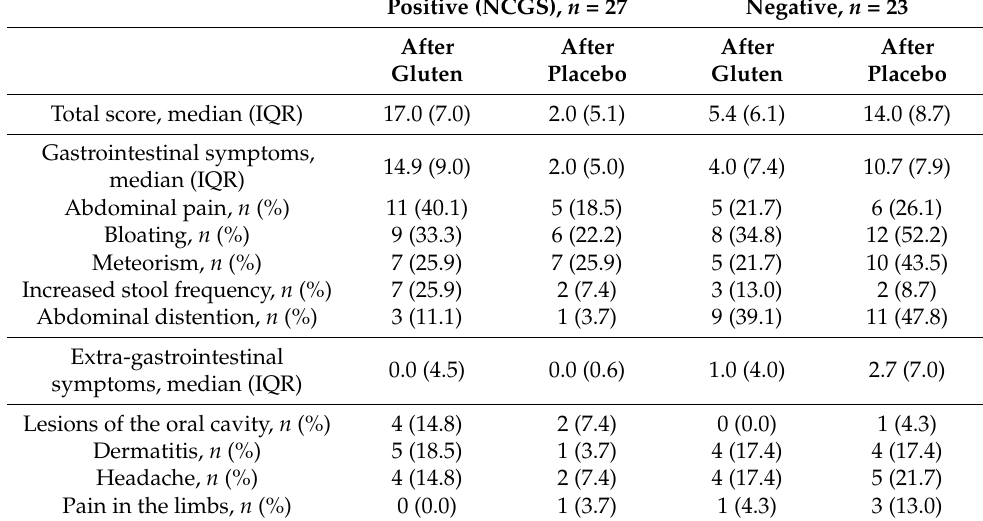
Table 2. Symptoms reported after the DBPC gluten